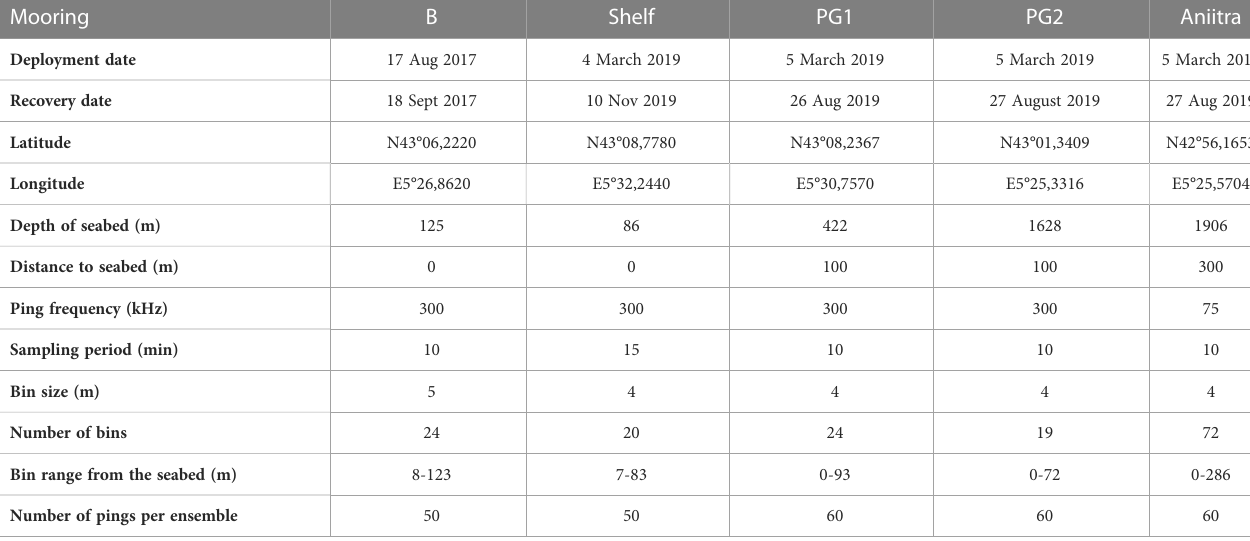
Bin range from the seabed (m)